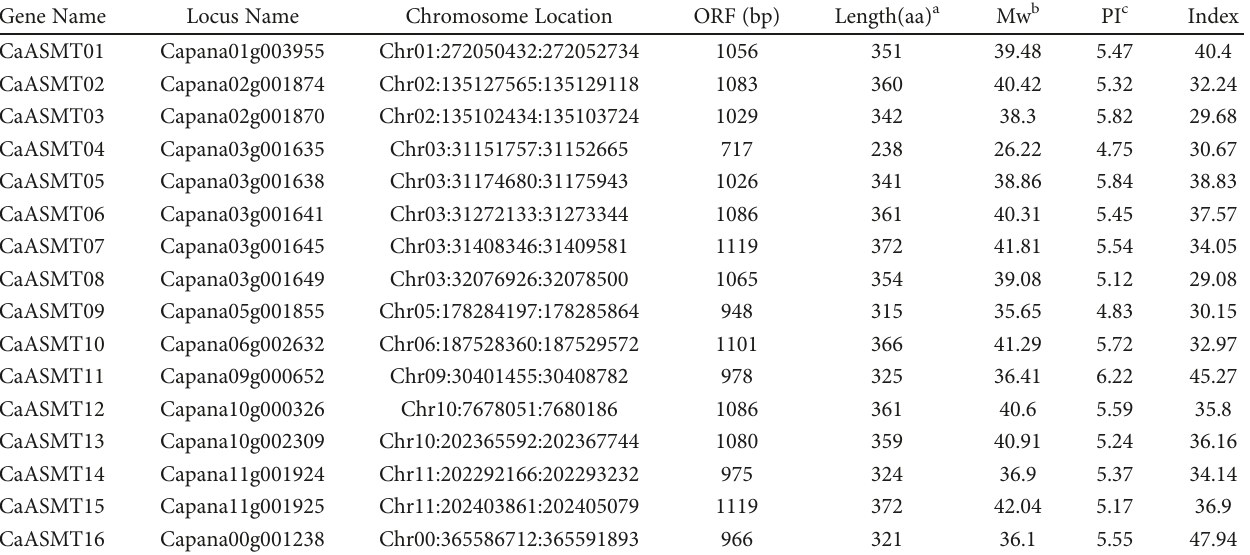
Table 1: The CaASMT genes in